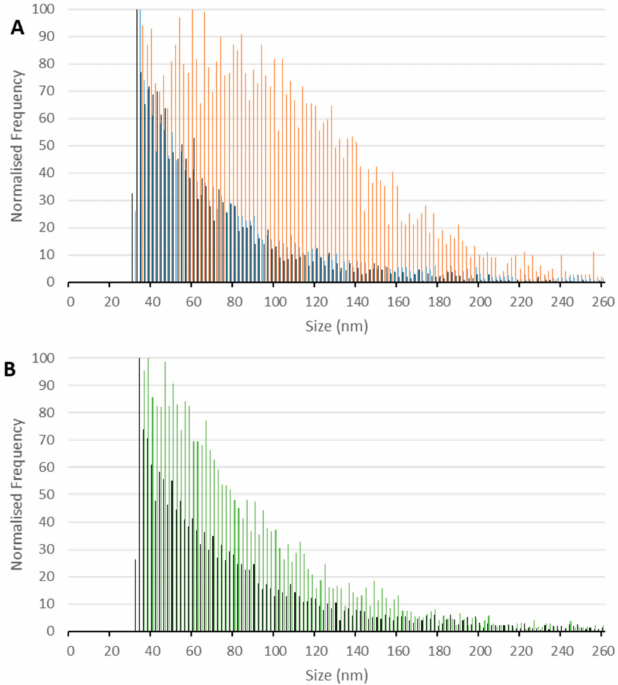
Figure 2. Size distribution of original SPIONs (( A ), orange), incubated with serum without (( A , B ); black) and with (( A ), blue) ultrafiltration, and incubated with albumin (( B ), green), without ultrafil- tration. The concentration of SPIONs in all suspensions—500 ng/L